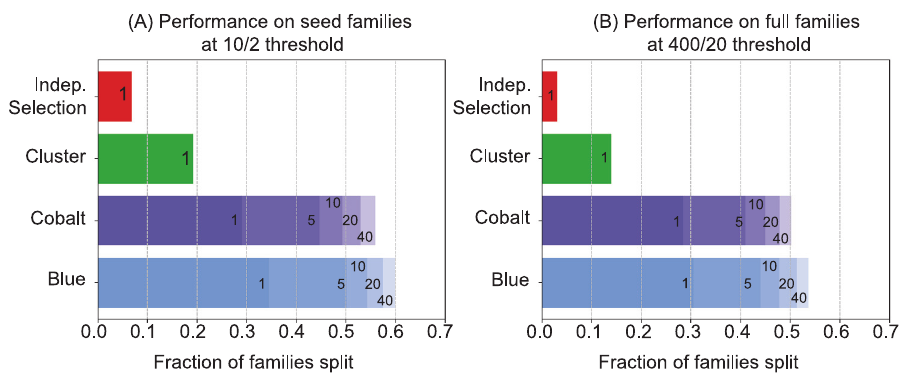
Fig 1. Performance of splitting algorithms on Pfam families. (A) Fraction of the 12340 Pfam seed families with at least 12 sequences that were split into a training set of size at least 10 and test set of size at least 2. The numbers on the Blue and Cobalt bars indicate the fraction of families successfully split at least once out of 1, 5, 10, 20, 40 independent runs. (B) Fraction of the 9827 Pfam families with at least 420 sequences in their full alignment that were split into a training set of size at least 400 and test set of size at least